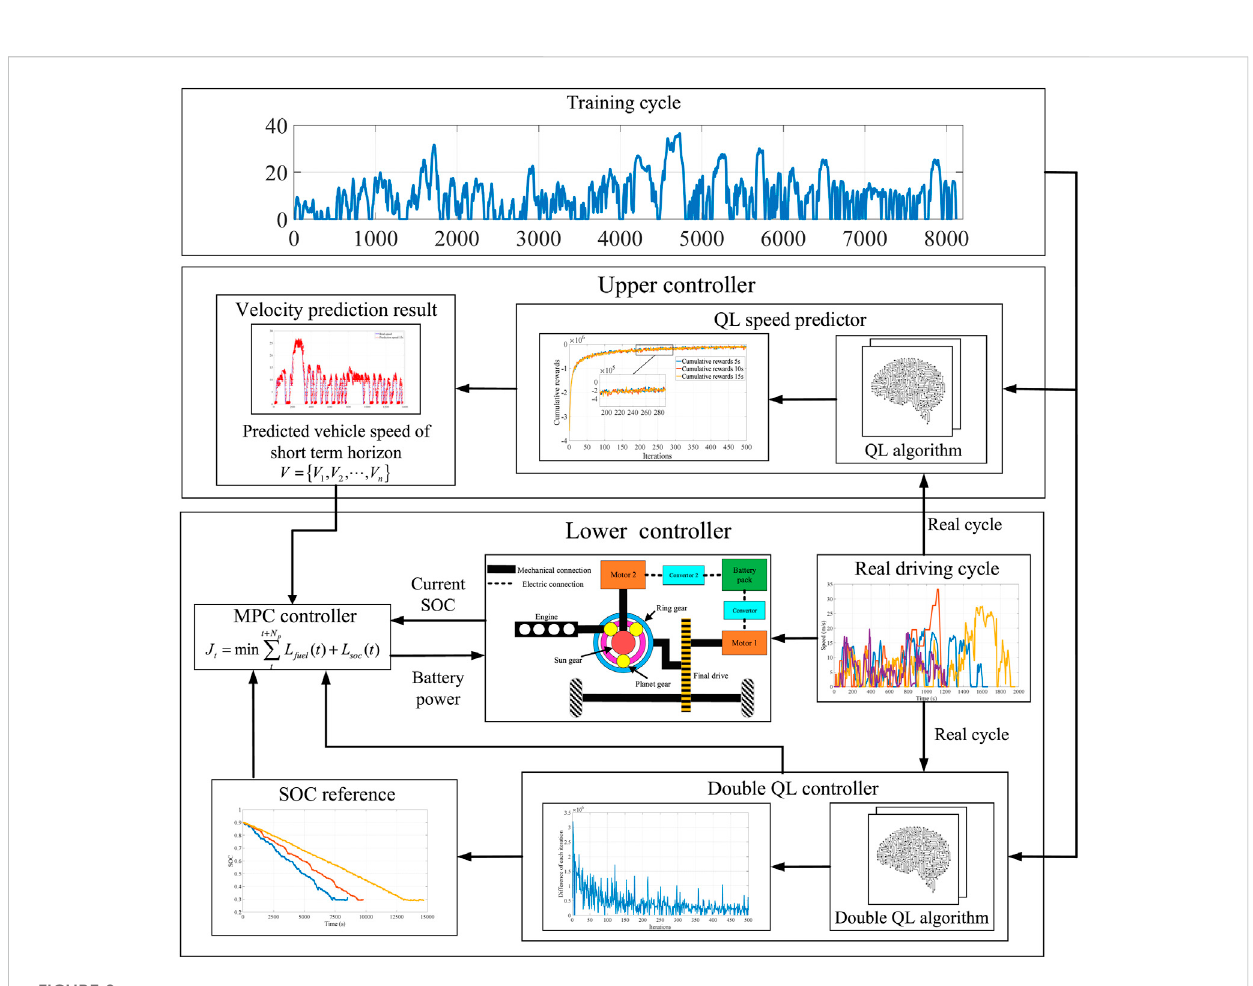
FIGURE 9 Framework of the bi-level